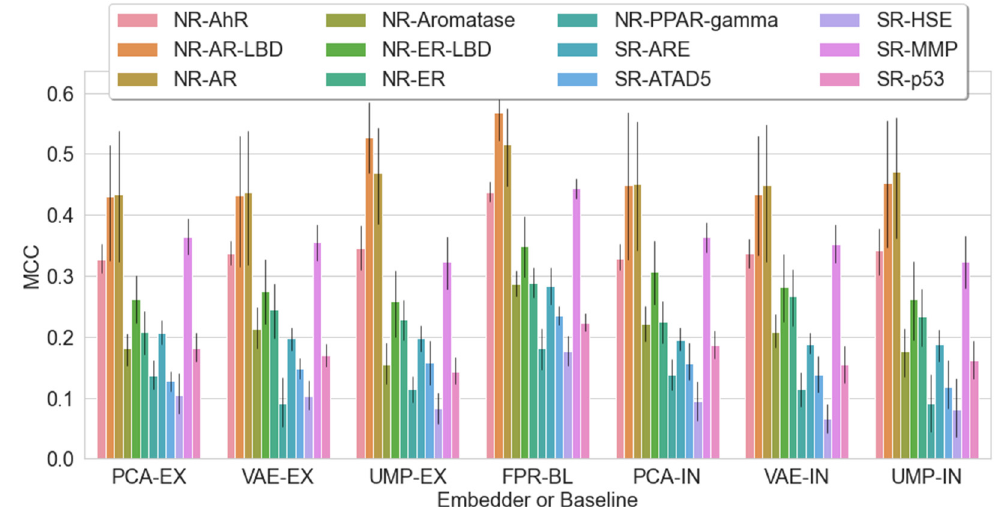
Figure 5. Comparison of machine learning classifications mean + error bar across all feature sets: FPR-BL = fingerprint baseline, PCA = principal component analysis (EX = external, IN = internal), UMP = uniform manifold approximation and projection, VAE = variational autoencoders. Each bar present nine runs (three classifiers × three random states). Table 3. Classification results across all data sets and labels expressed by maximum values of the MCC. The fingerprint- based model maxima (FPR-BL) were set as 100%, while the embedding models referred to these 100%. Results assigned with an asterisk (*) outperformed